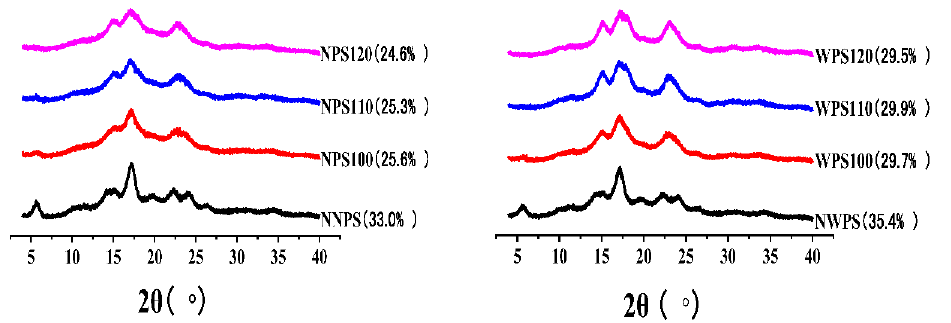
Figure 6. X-ray diffraction patterns of the